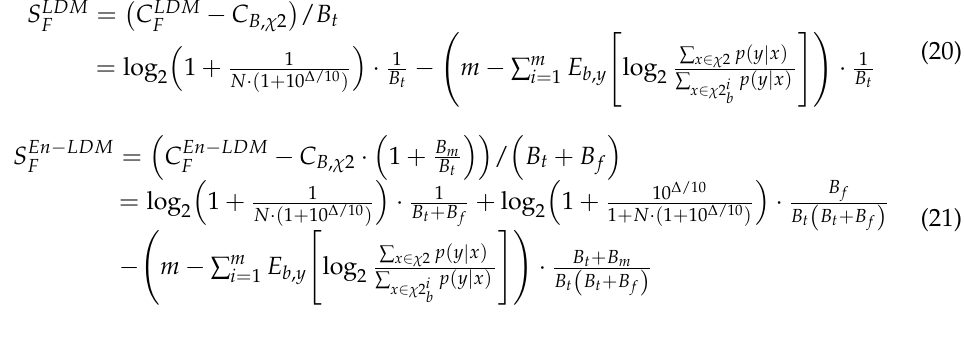
Figure 3. The shortfall from Shannon for the mobile service of the LDM and En-LDM systems under the AWGN and Rayleigh channels, where the parameters of the LDM and En-LDM systems were set to ∆ = 10 dB, B f / B t = 1/4, the constellation for the mobile service was set to